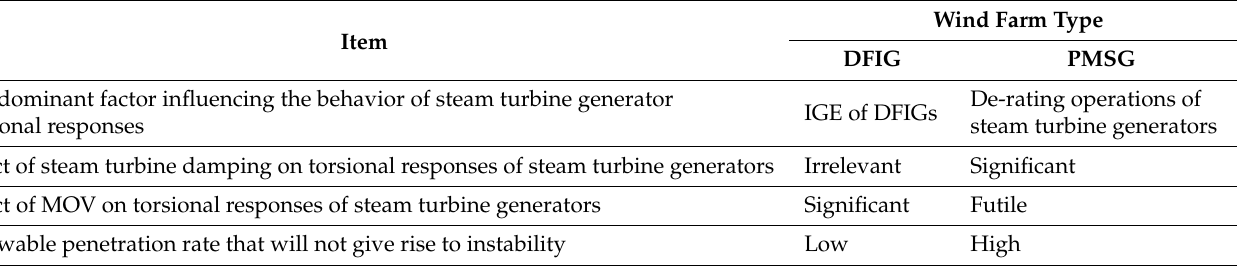
Table 8. Summary of the comparative studies.